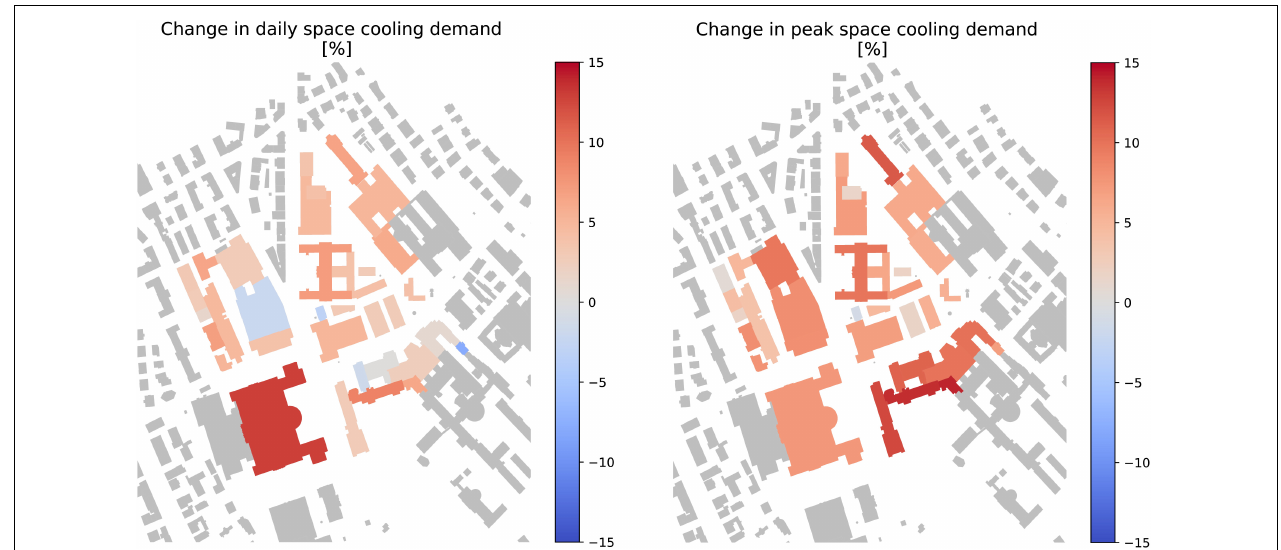
FIGURE 13 | Change in total and peak cooling demand on the selected day due to the effect of microclimate for each building in the